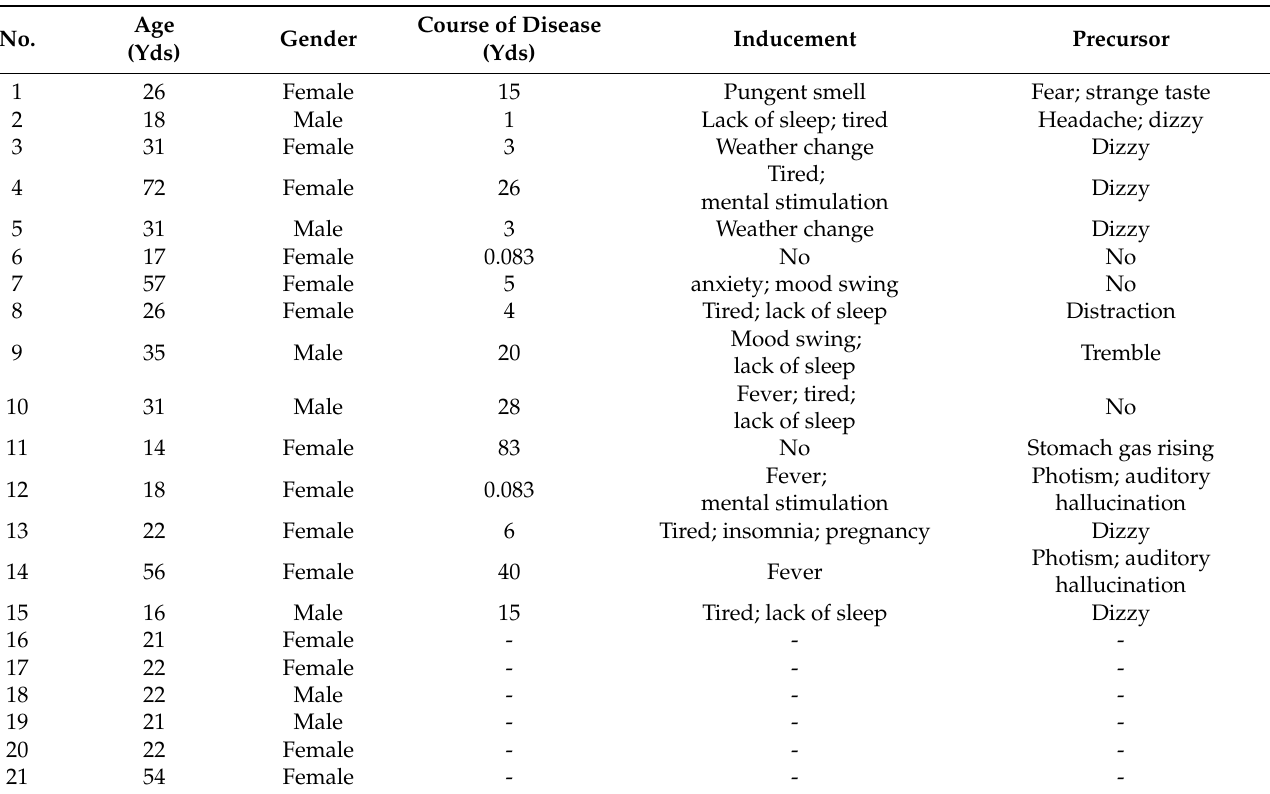
Table 1. All participants’ information.